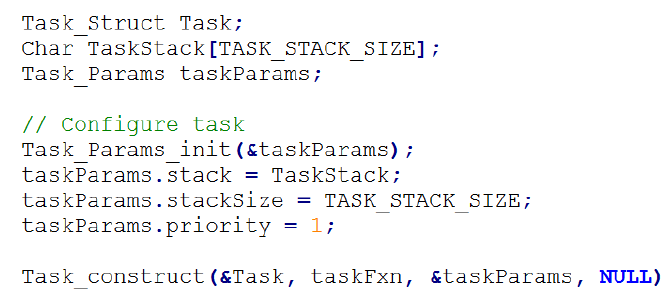
Figure 4. Typical method in a real-time operating system (RTOS) to instantiate task taskFxn with the task parameters configured in a structure.